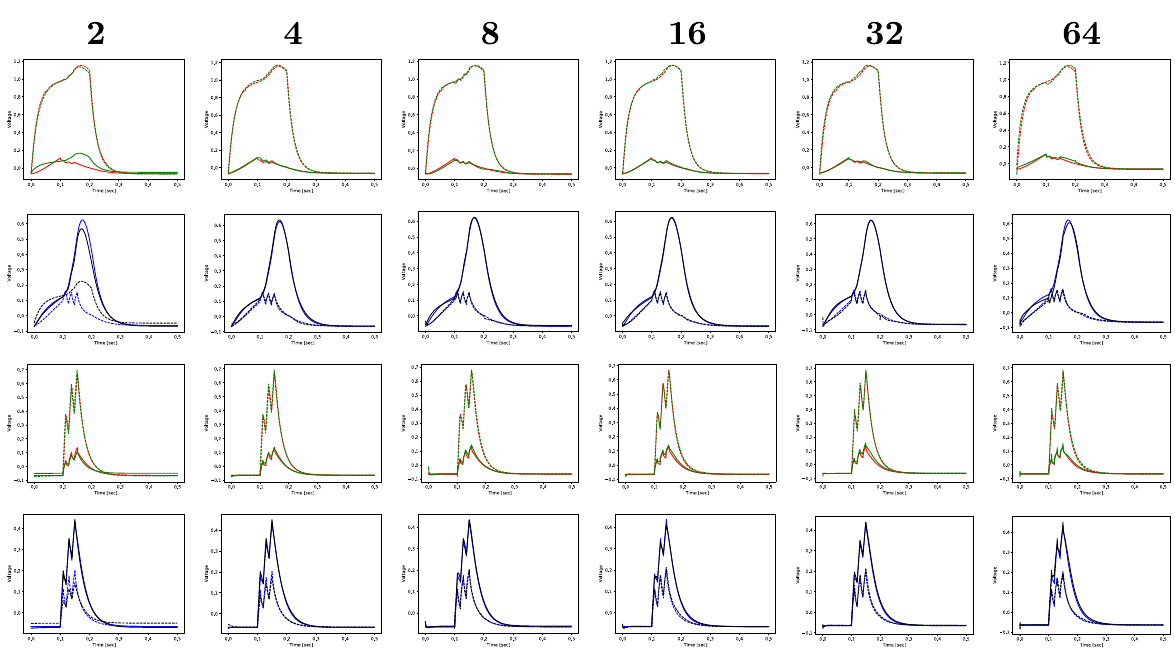
Figure 8. Experiment 2: realistic (red and blue) and predicted (green and black) sequences for DB1 and LUAL (1st and 3rd rows) and PVR and VB1 (2nd and 4th rows) for two sequences of the test set (one selected simulation out of